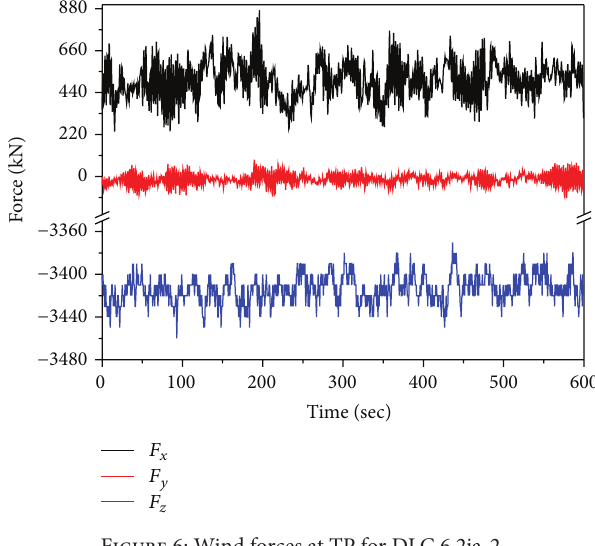
Figure 6: Wind forces at TP for DLC 6.2ja-2.